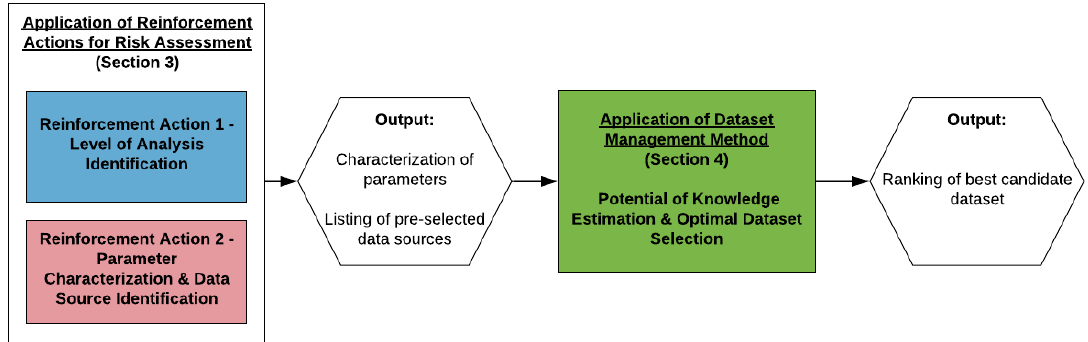
Figure 6. Logic of steps for applying the data management method. The reinforcement actions applied on common risk assessment frameworks provide the parameter characteristics required for a QRA, as well as a list of data sources that can be used to inform those.